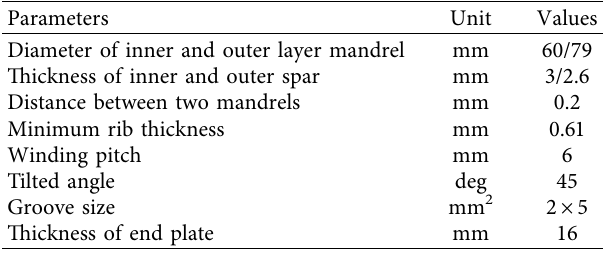
Figure 3: Assembly of the CCT quadrupole prototype. Table 1: Parameters of the quadrupole magnet